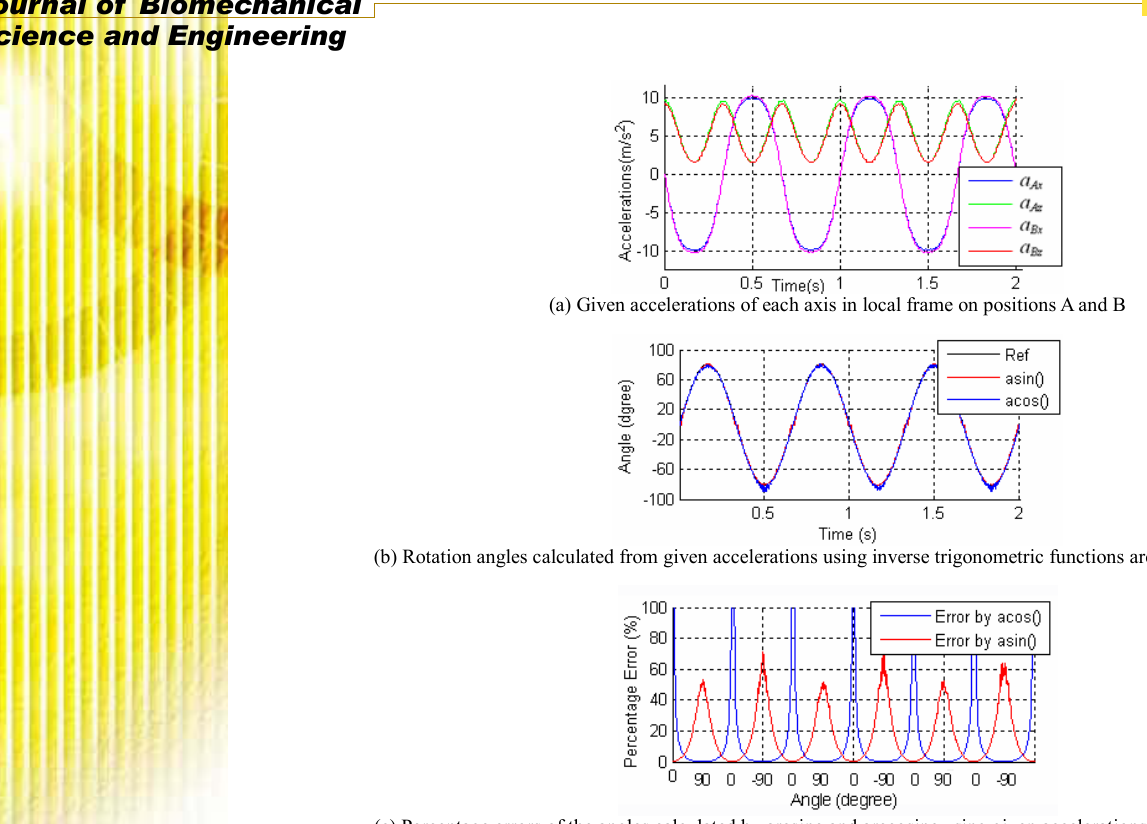
Fig. 4 Simulation results using given signals (accelerations) in the reference frame. Ref means given signal, asin means calculated by arcsine, acos means calculated by arccosine, error by acos means the error when angles are calculated by arccosine, error by asin means the error when angles are calculated by arcsine